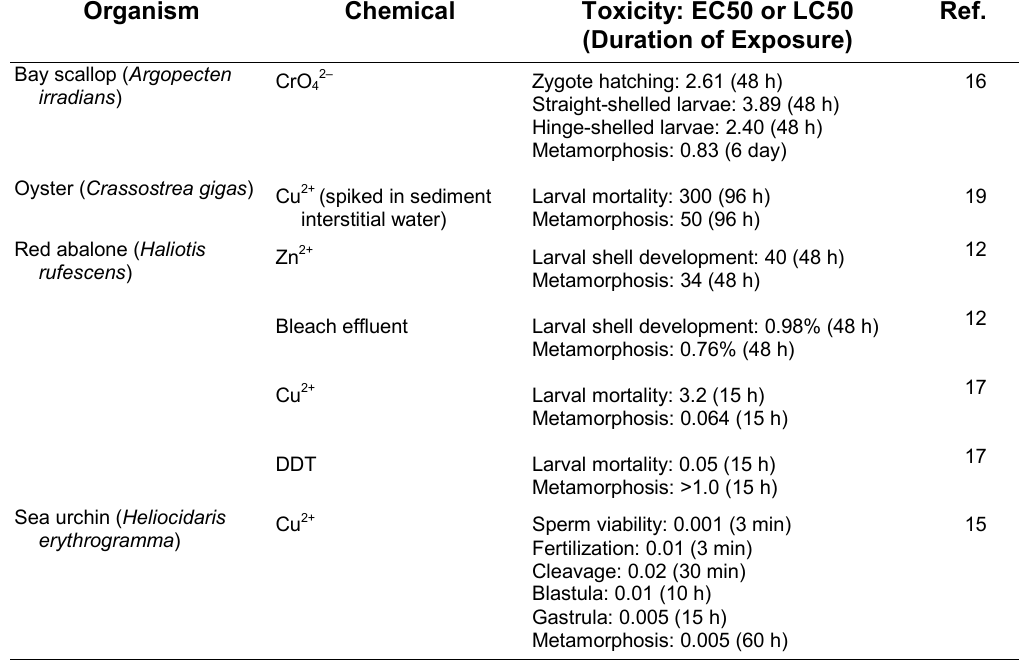
Toxicity of Chemicals (mg/dm 3 ) to Different Life Stages of Marine Invertebrates Organism Chemical Toxicity: EC50 or LC50 (Duration of Exposure)